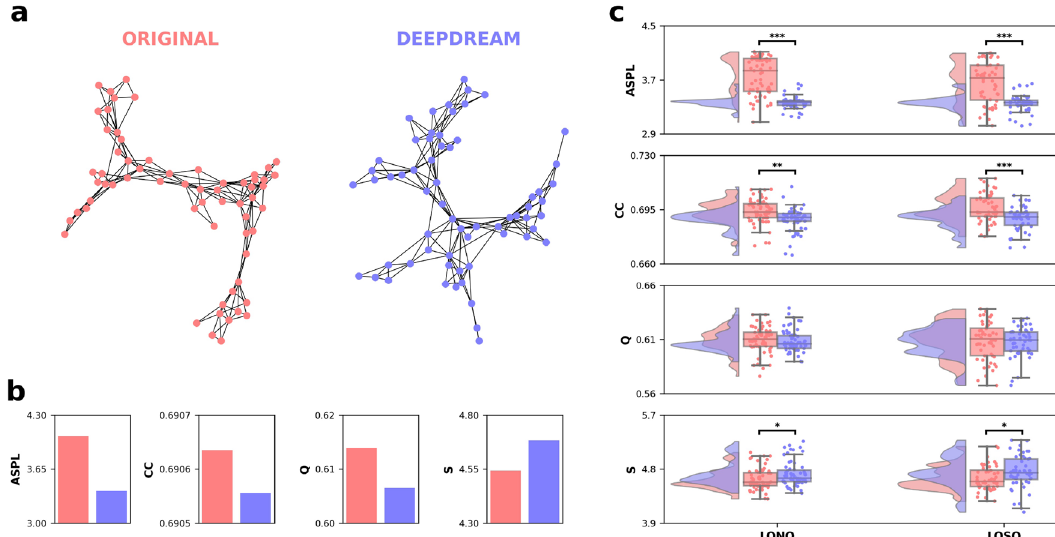
Figure 2. Semantic networks, topological quantifiers and statistical results. ( a ) Undirected, unweighted semantic networks of the OR and DD conditions, visualized using the spring layout, with nodes as unique AUT responses and edges as cosine similarity. ( b ) Barplots depicting the topological quantifiers of the full networks. ( c ) Raincloud plots represent the results from the LONO and LOSO procedures on the topological quantifiers. Horizontal black bars represent statistical significance.